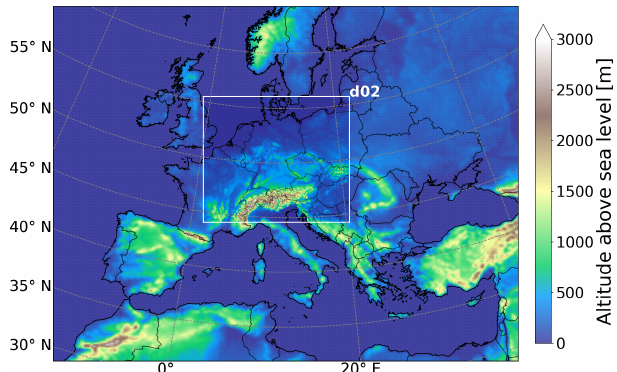
Figure B1. Nested model domains d01 (full figure) and d02 (marked panel) of the WRF